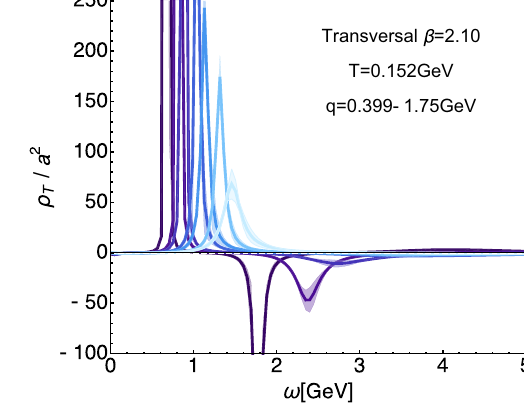
showcase the existence of negative contributions. One can clearly see a well defined lowest lying positive peak with a subsequent trough, which dies out towards higher frequencies. Error-bands arise from varying the default-model functions m and h